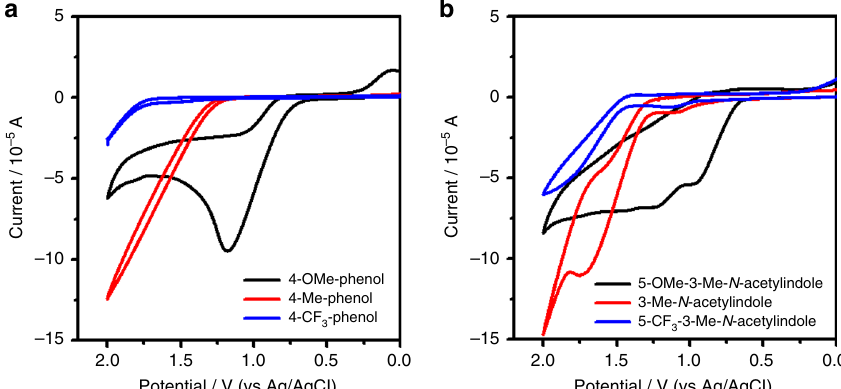
Fig. 6 Cyclic voltammograms in HFIP/CH 2 Cl 2 with 0.20 M n Bu 4 NBF 4 . a Cyclic voltammograms of different phenols. b Cyclic voltammograms of different N